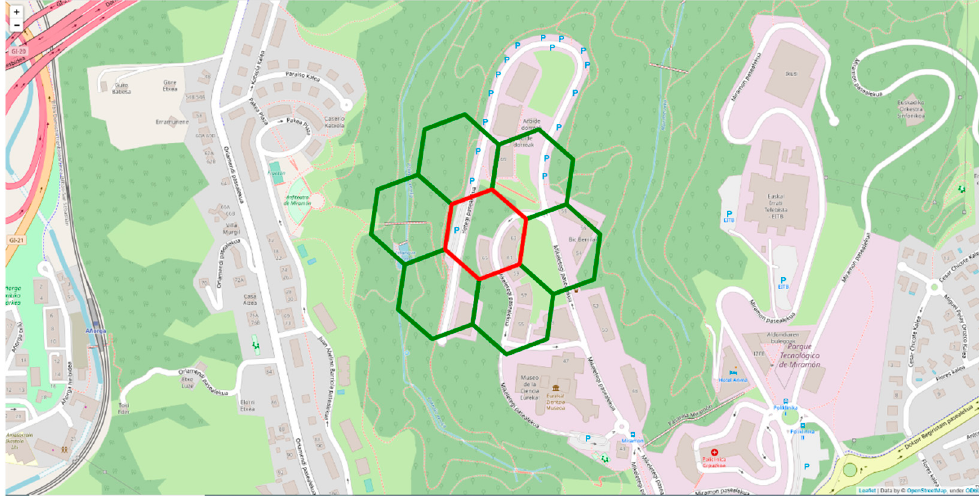
Figure 5. H3 hexagons of a given vehicle position and its outer ring for resolution = 10.